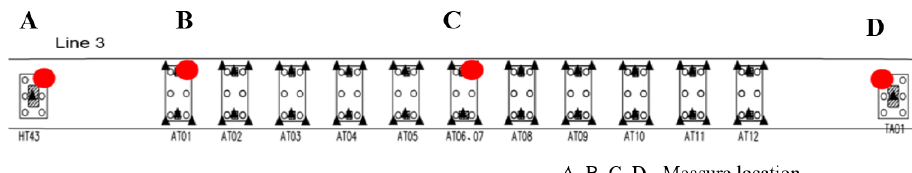
Figure 8. Layout of measuring points of different piles.